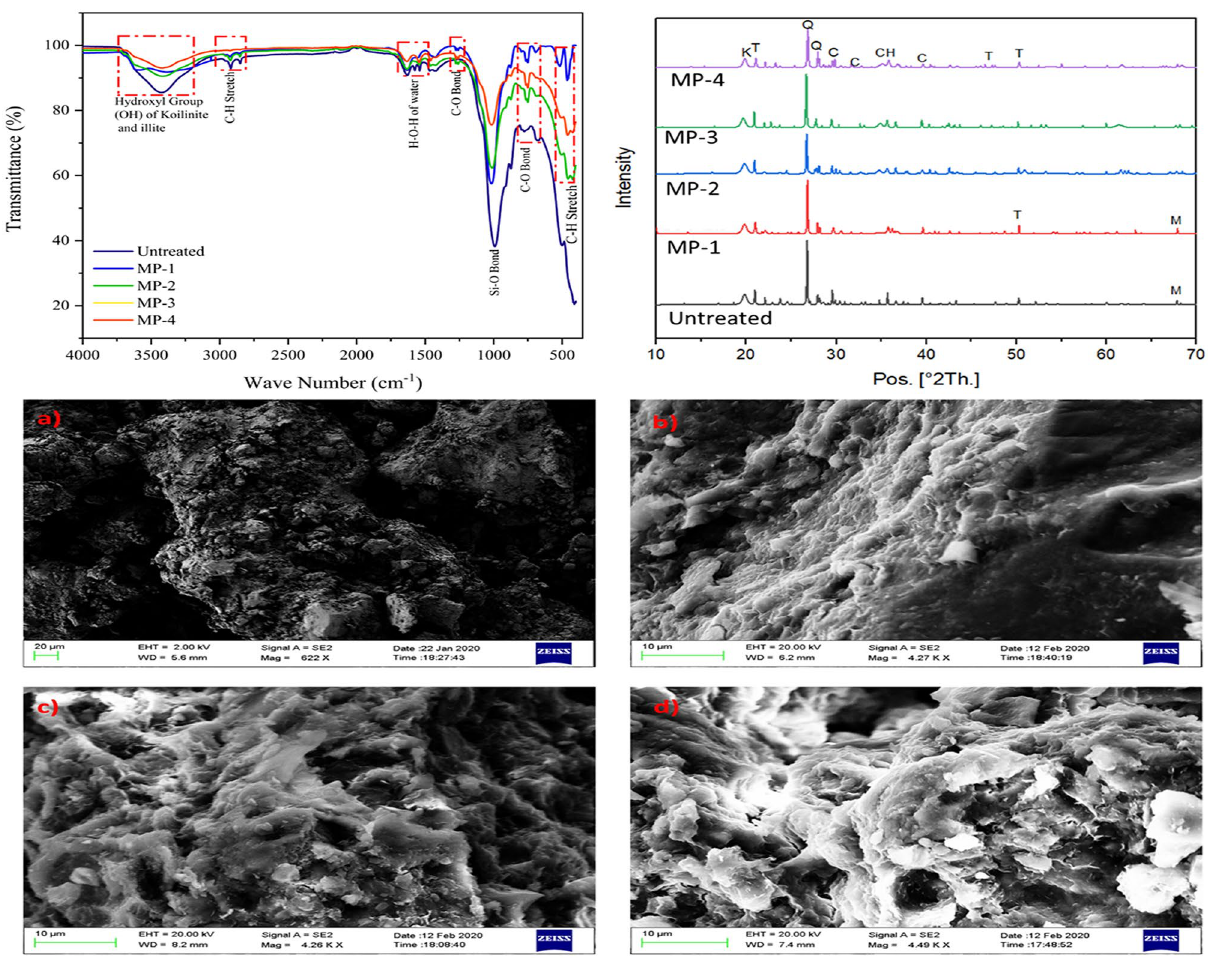
Figure 3. FTIR, XRD and SEM micrograph of MICP untreated and treated expansive